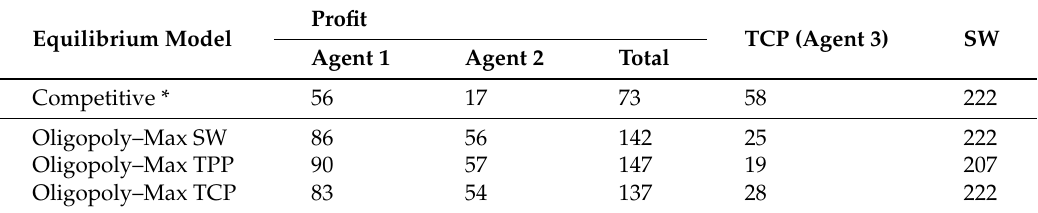
Table 3. Case study: profits and social welfare ($ thousand) under different equilibrium models. Equilibrium Model